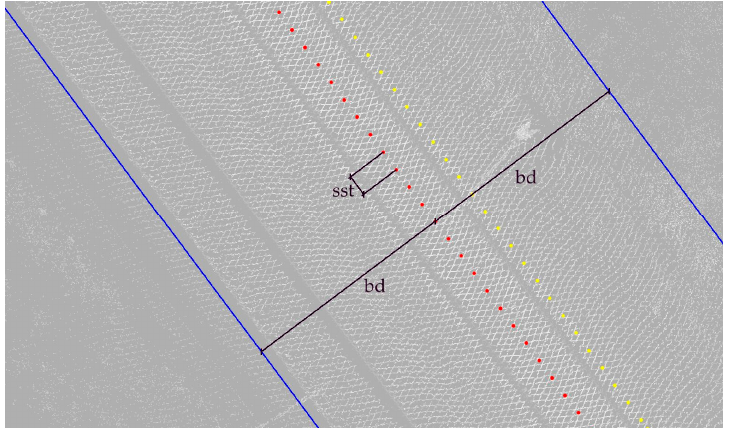
Figure 7. Sample point cloud. In red trajectory key points (KP), in yellow directional points, in blue border of calculation area.